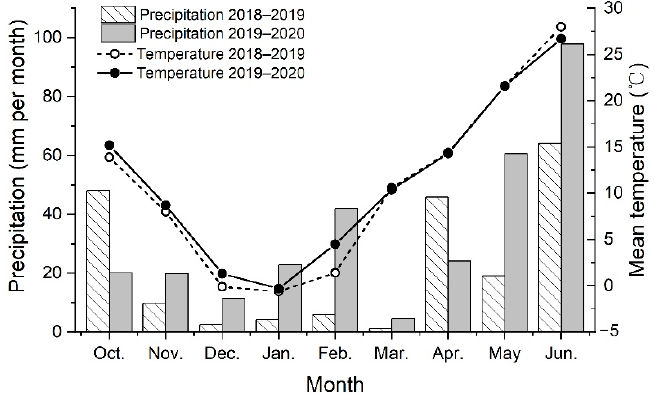
Figure 1. Monthly mean temperatures and total precipitation during 2018–2019 and 2019–2020 winter wheat growing seasons.